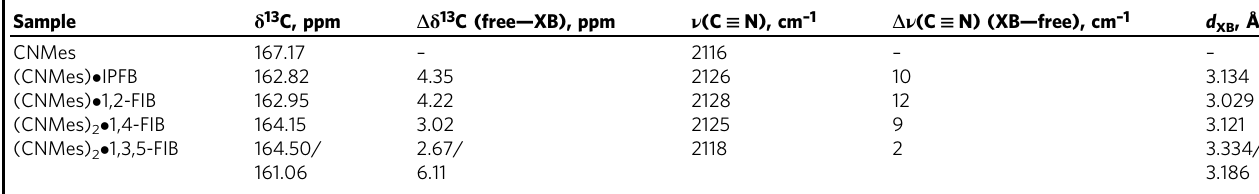
Table 2 13 C NMR chemical shifts and IR ν (C ≡ N) values in the solid state for CNMes and its adducts. Sample δ 13 C, ppm